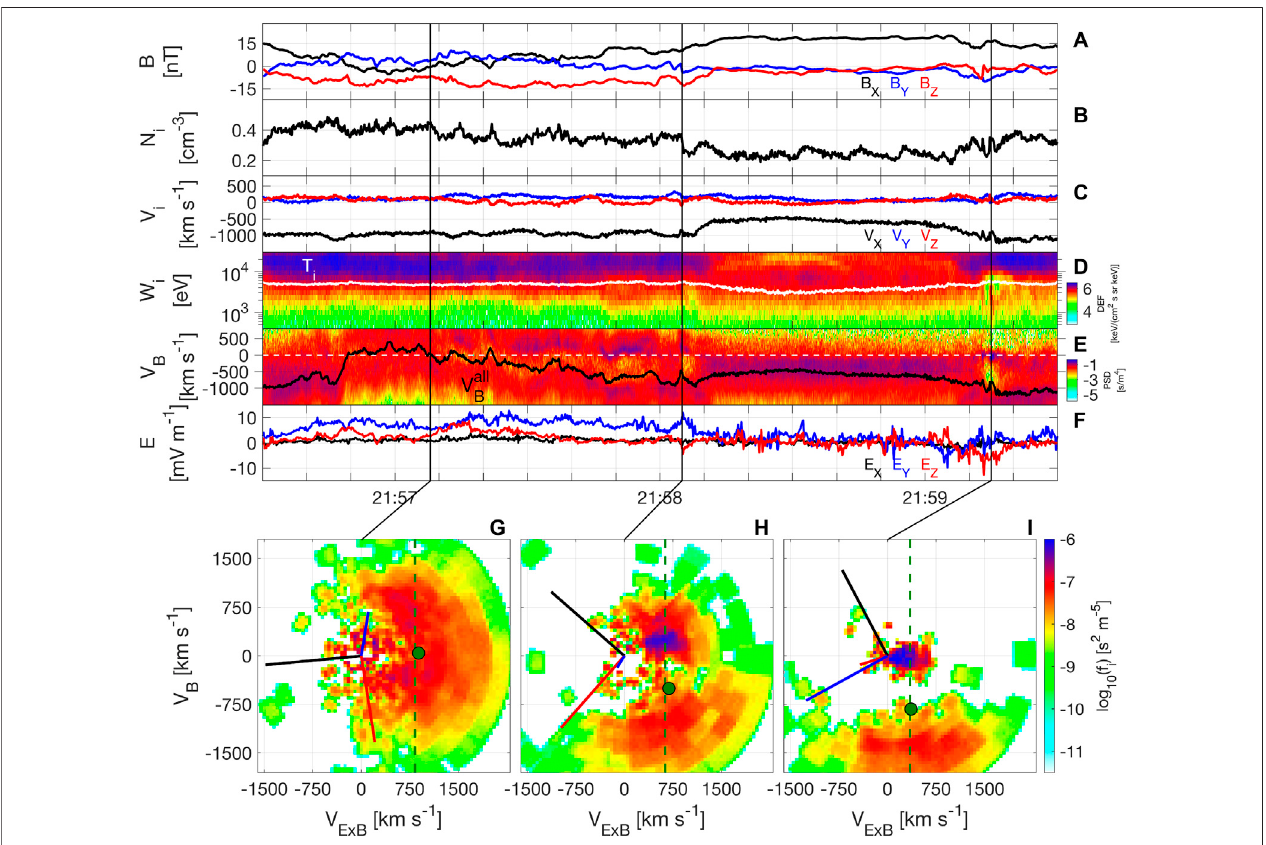
FIGURE 2 | Cold ions inside the tailward ion jet. (A) B . (B) N i . (C) V i . (D) FPI ion omnidirectional differential energy fl ux with ion temperature (white curve). (E) Reduced ion VDF integrated over the directions perpendicular to the magnetic fi eld. The black solid curve shows the parallel ion bulk speed V all B of all ions, and the white dashedlinedenotesV B (cid:2) 0. (F) Electric fi eld E . (G) – (I) Two-dimensional(2D)reducedionVDFsinthe V ExB - V B planeattimesindicatedbythethreeverticallinesin (A) – (F) . In (G) – (I) , the green dots represent the ion bulk velocities, and the vertical green dashed lines show the electric- fi eld drift speeds (|E × B / B 2 |) . The GSE-X (black), Y (blue) and Z (red) directions normalized by 1,500 km s − 1 are projected in (G) – (I)